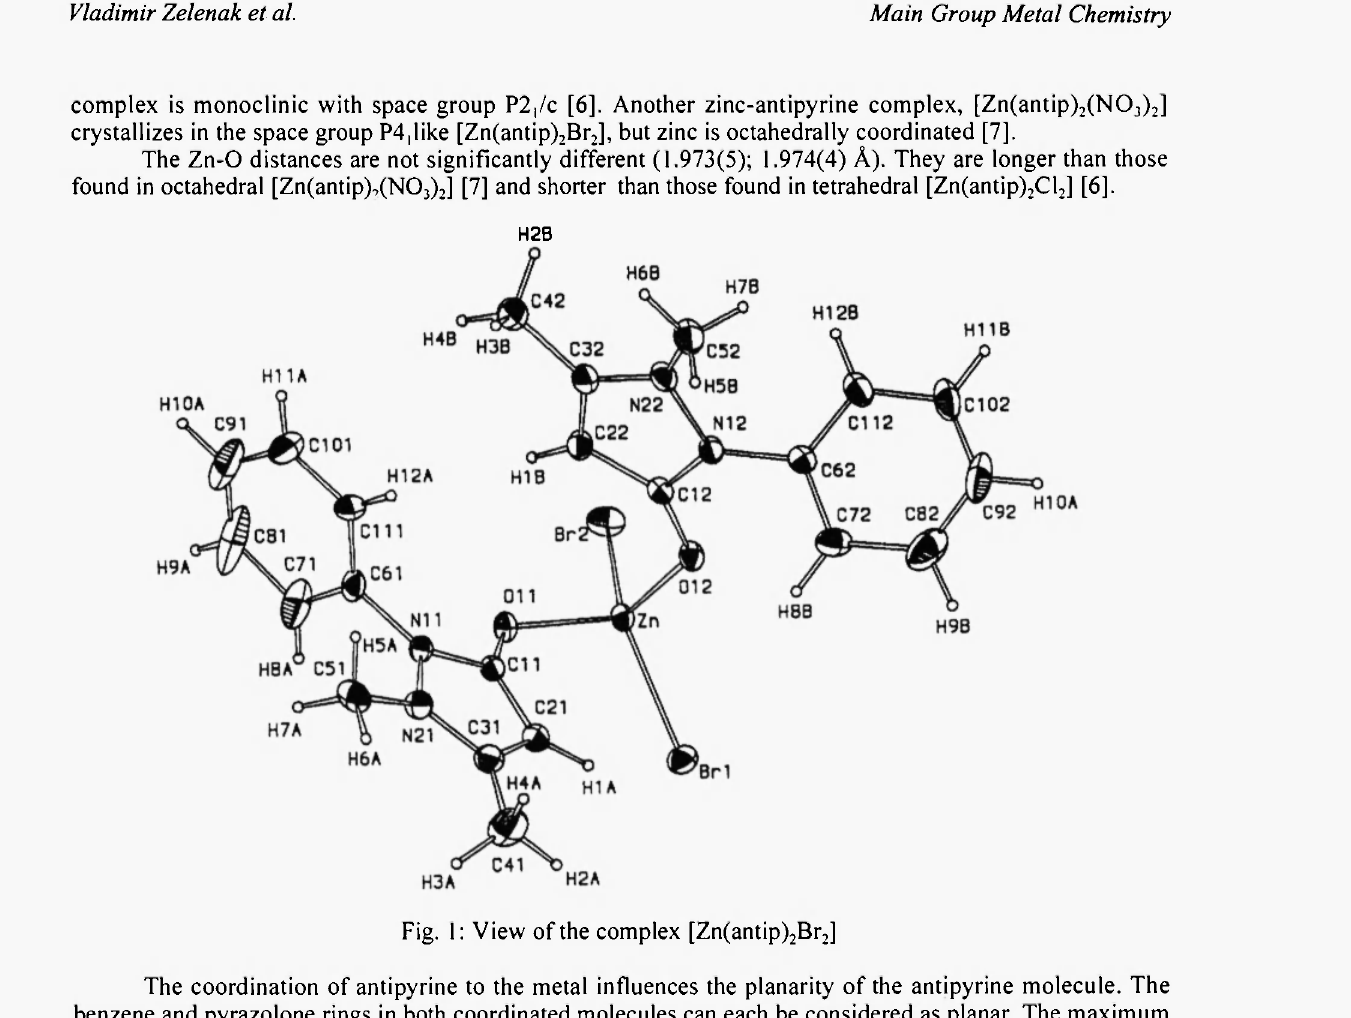
Fig. 1: View of the complex [Zn(antip) 2 Br 2 ]